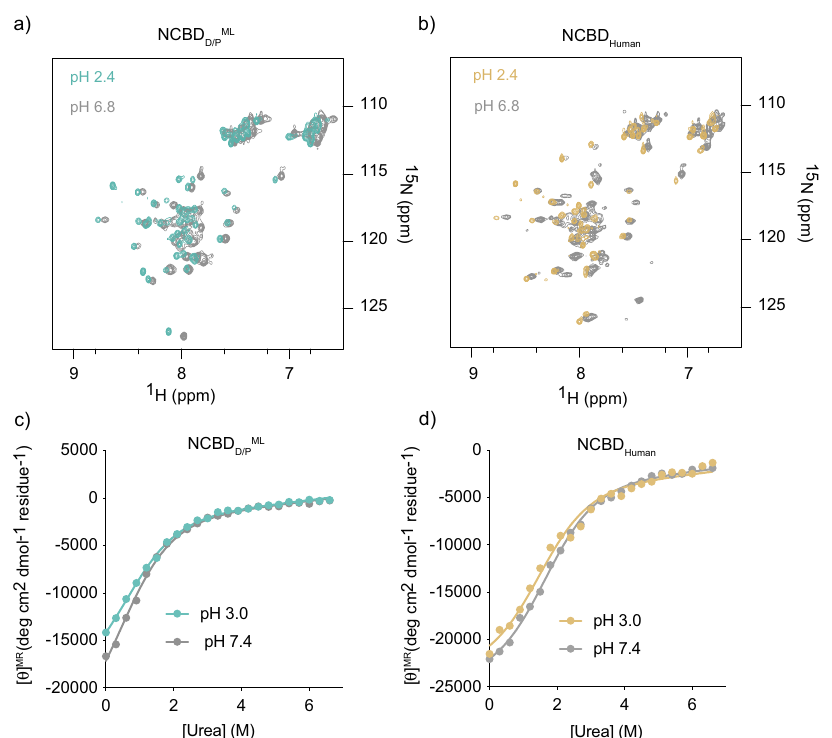
Fig. 4 Comparison of ancestral NCBD D/P ML and extant NCBD Human at two different pH values. a Overlay of the 1 H- 15 N HSQC spectra of NCBD D/P ML at pH 2.4 (teal) and at pH 6.8 (gray). b Overlay of the 1 H- 15 N HSQC spectra of NCBD Human at pH 2.4 (gold) and at pH 6.8 (gray). c Urea denaturation experiments for NCBD D/P ML at pH 3.0 (teal) and at pH 7.4 (gray). d Urea denaturation experiments for NCBD Human at pH 3.0 (gold) and at pH 7.4